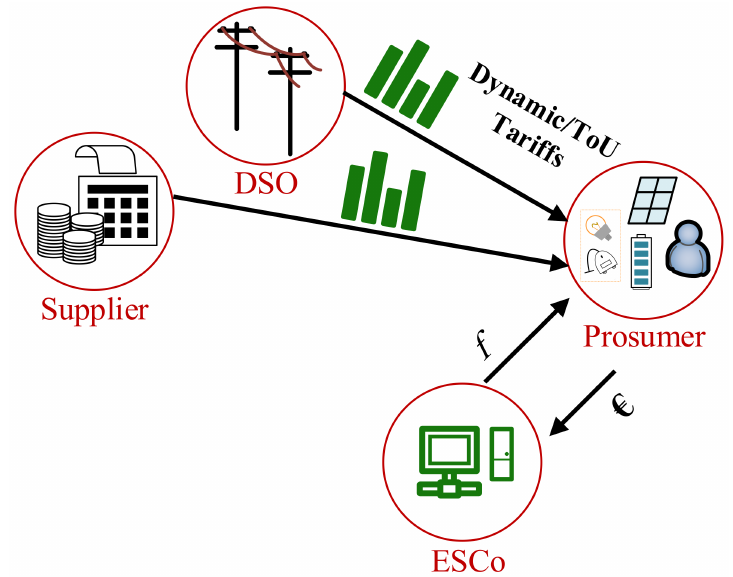
Figure 4. Information and money flow among the participants of LEMs in price-based